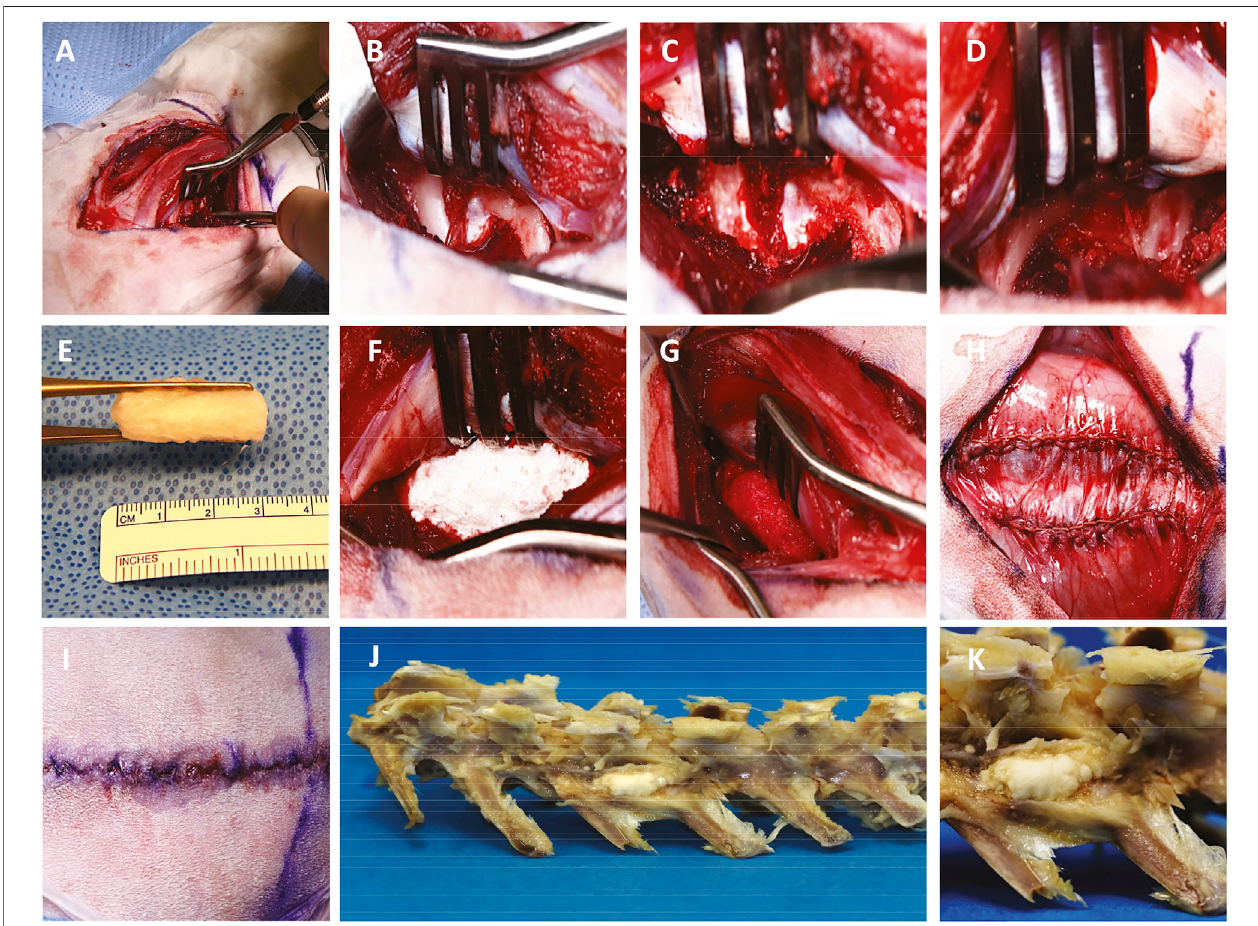
FIGURE2| Operativetechniqueofposterolaterallumbarspinalfusion.Dissectionthroughtheskinandintermuscularplanes (A) exposesadjacentlumbarvertebral bodies and transverse processes (B) which are prepared by decortication (C, D) for fusion using a customized 3 cm nanocomposite MHA/Coll scaffold (E) either alone (F) or soaked in autologous PRP (G) . The tissues are closed with absorbable suture and skin glue (H, I) and harvested at 6 weeks postoperatively (J, K) .